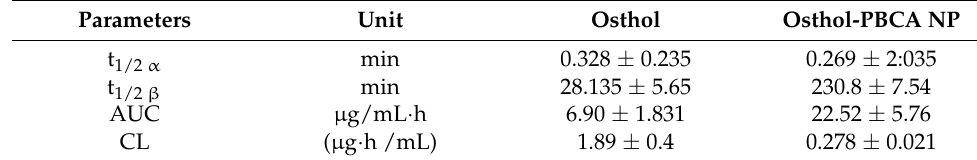
Figure 9. Plasma drug concentration – time cures of osthol after administration of 5 mg·mL −1 osthol free or in osthol-PBCA NP suspension via the tail veins of rats. Table 7. PK parameters of osthol and osthol-PBCA NPs in rats ( 𝛸 ± S, n = 9).